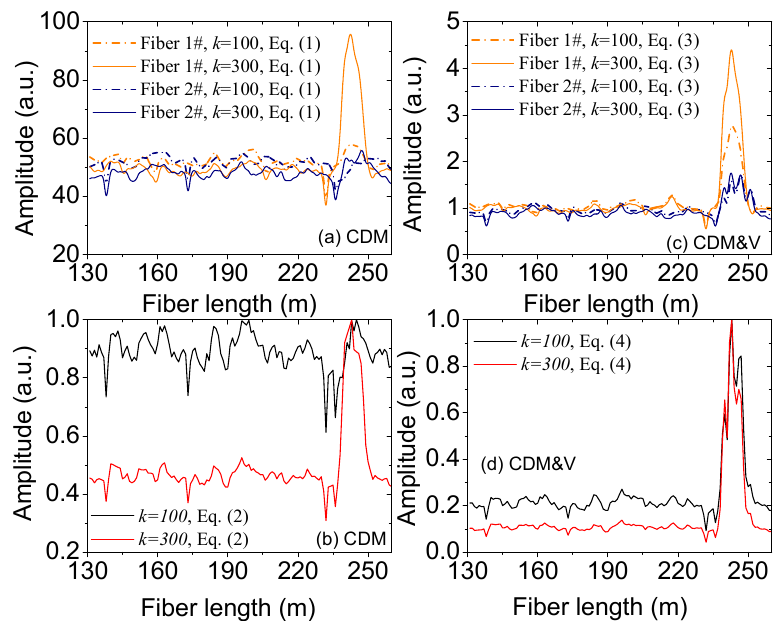
Figure 3. Accumulated vibration signals at 242 m for different differential steps by ( a ) the CDM based on Equation (1) and ( c ) the CDM&V based on Equation (3) in fiber 1# and fiber 2#, respectively. Synthesized signals for different k values by ( b ) the CDM based on Equation (2) and ( d ) the CDM&V based on Equation (4). In the figure, 2500 consecutive Rayleigh traces are measured for each fiber.